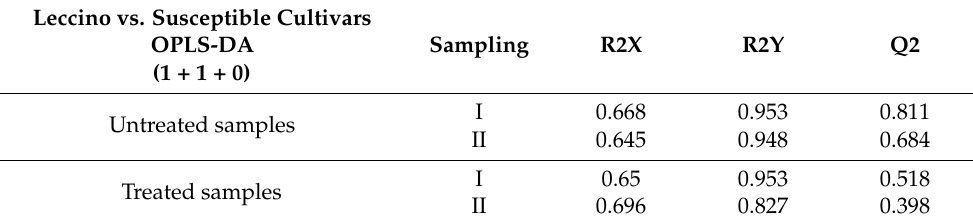
Table 4. Statistical parameters of supervised OPLS-DA models for first (I) and second (II) sampling periods in the treated and untreated naturally infected Leccino and susceptible cultivars. R2X and R2Y indicate the fraction of variance of the X and Y matrix, respectively. Q2 is a goodness of prediction parameter representing the portion of variance in the data predictable by the model.